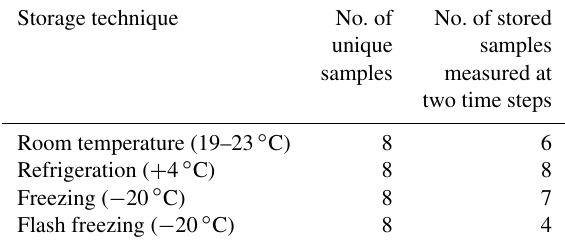
Table 3. Summary of unique and replicate heat-treated precipita- tion samples used for INP concentration measurements featured in Fig. 3. Storage technique No. of No. of stored